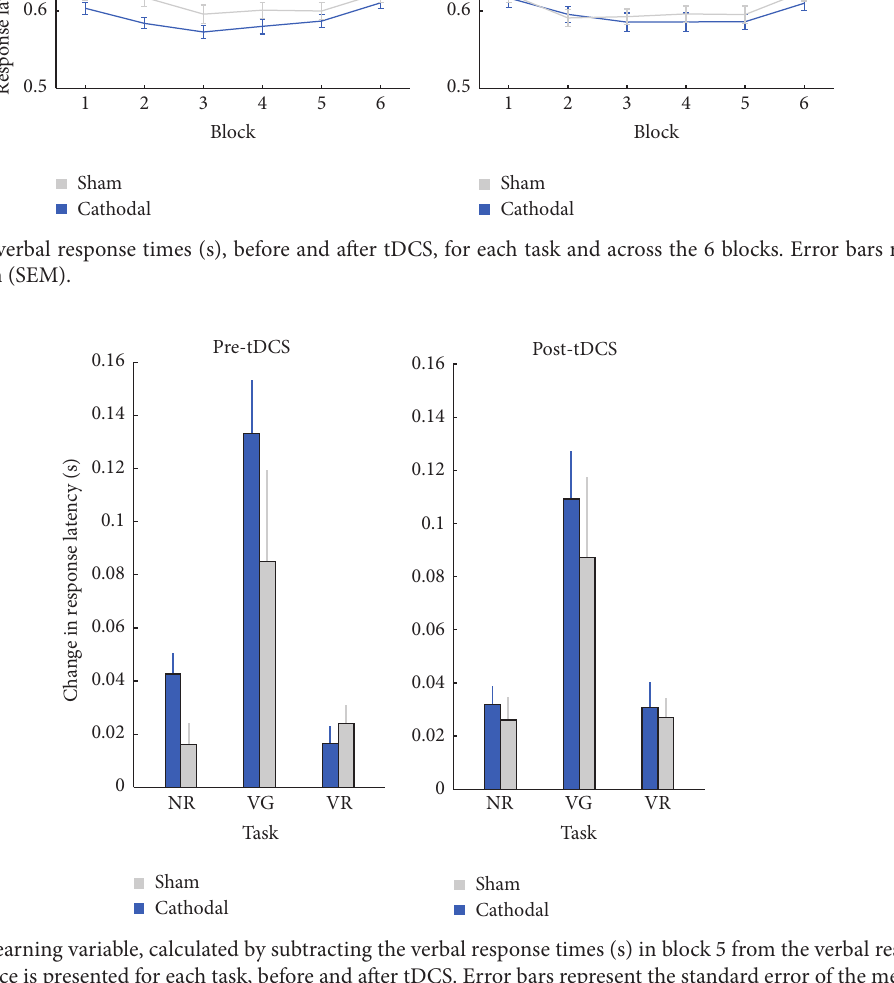
generation task ( 0.104 ± 0.015 s), compared to noun reading ( 0.029±0.005 s) and verb reading ( 0.025±0.004 s). In contrast with the study of Pope and Miall, the present study did not demonstrate a Condition × Session × Task